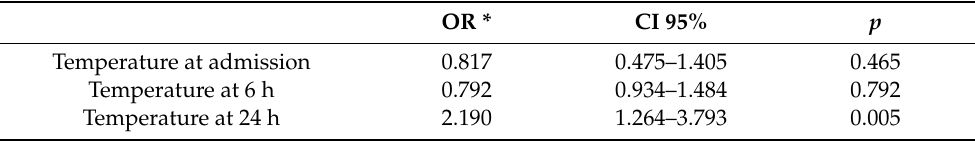
Table 3. Logistic regression model for temperature at three different time points showing the relationships to poor outcomes at 3 months. OR * CI 95% p Temperature at admission 0.817 0.475–1.405 0.465